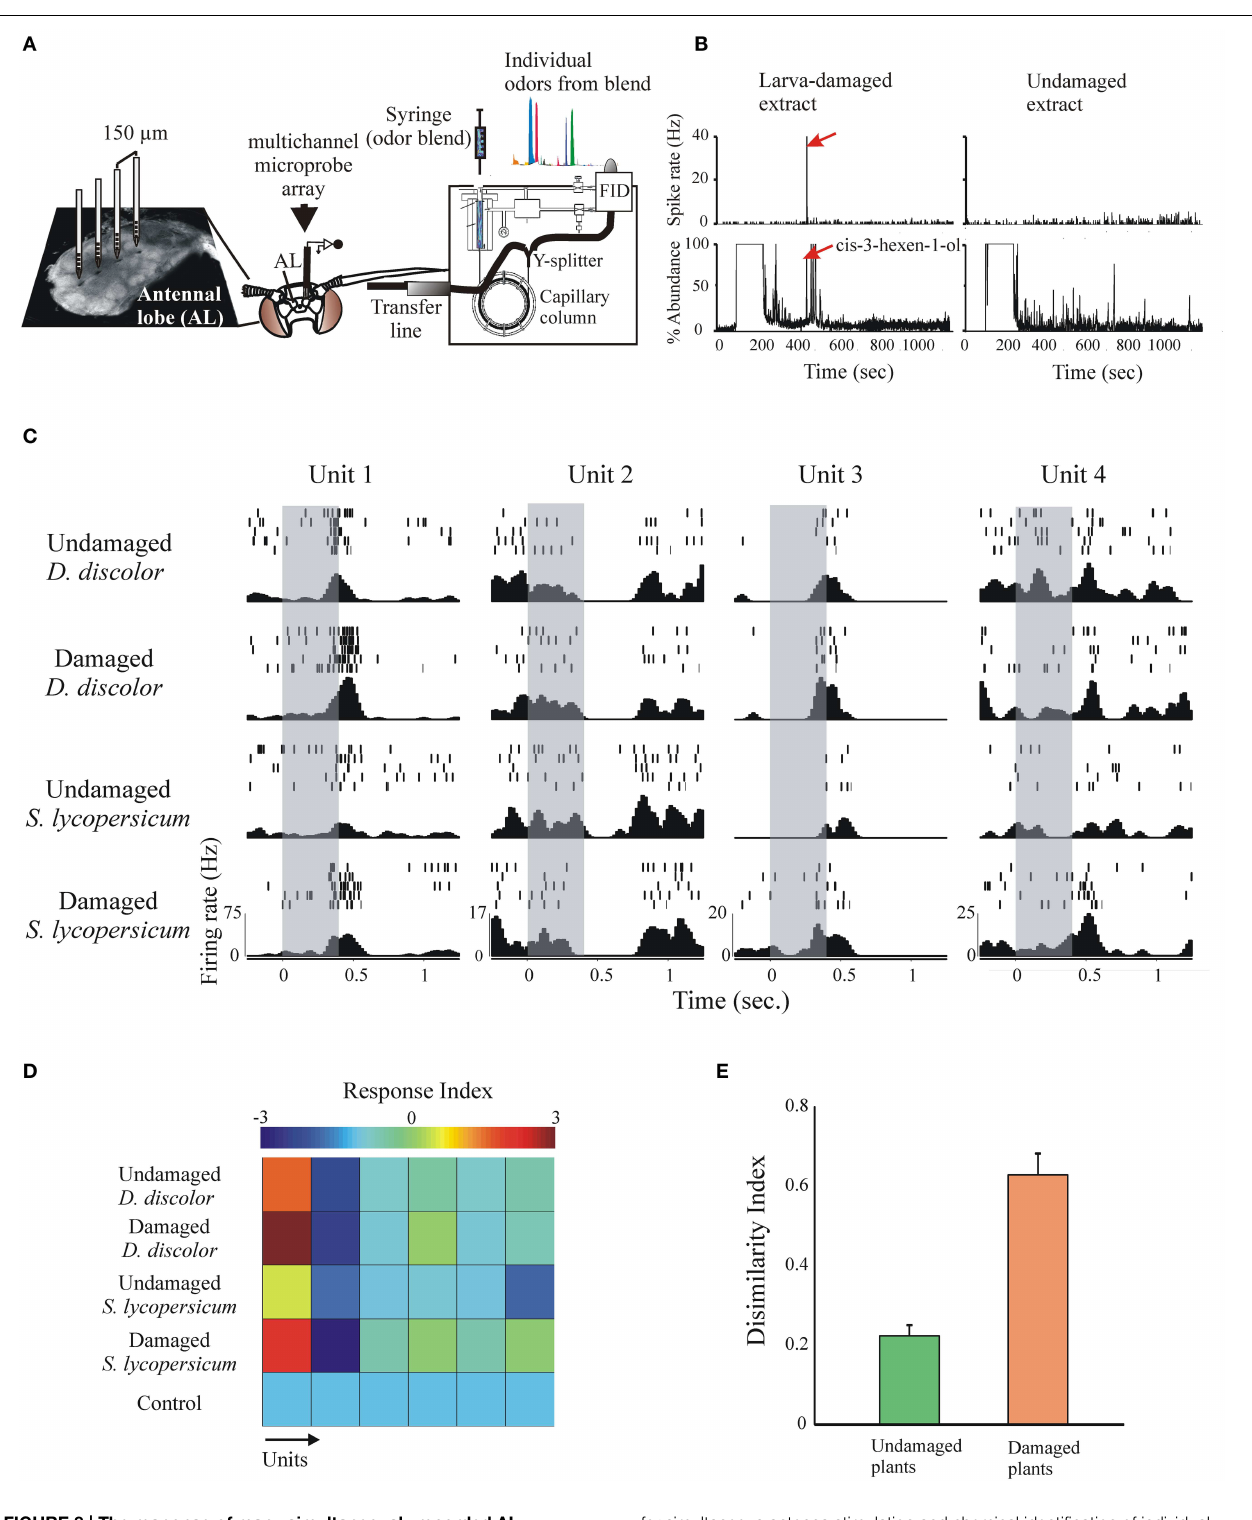
FIGURE 8 | The response of many simultaneously recorded AL neurons to VOC extracts and single components can be studied using a multi-unit recording electrode coupled to gas-chromatographic analysis (GC-MRA). (A) Plant extracts are injected on the GC inlet; after leaving the GC column a Y-splitter divides the effluent